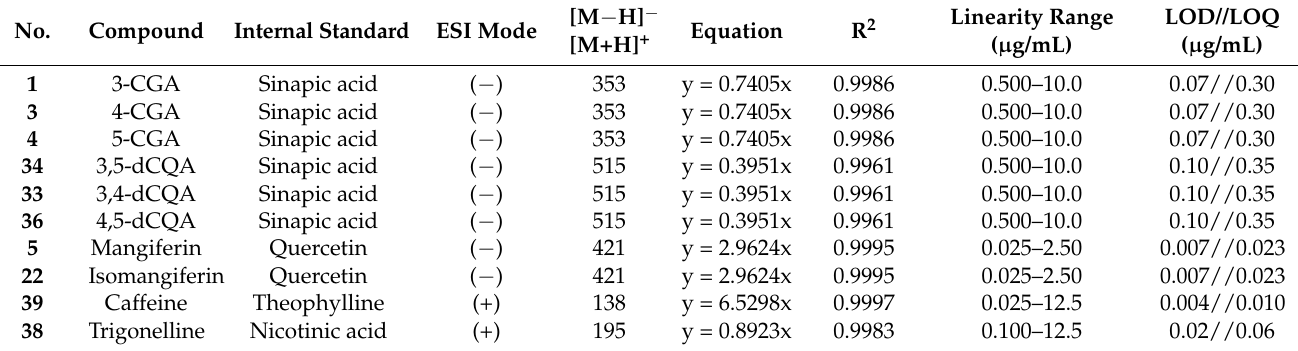
Table 1. List of the quantified compounds in the C. arabica extracts with the relative internal standards and ESI ionization mode and calibration curve